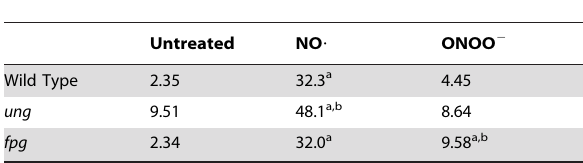
Table 1. Mutability of S. Typhimurium strain 14028s derivatives upon exposure to nitric oxide (NO ? ) or peroxynitrite (ONOO 2 ).